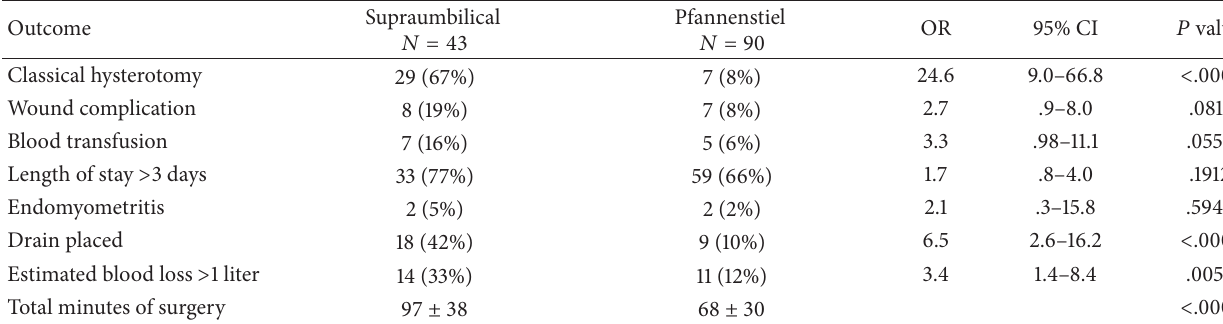
Table 2: Outcomes.